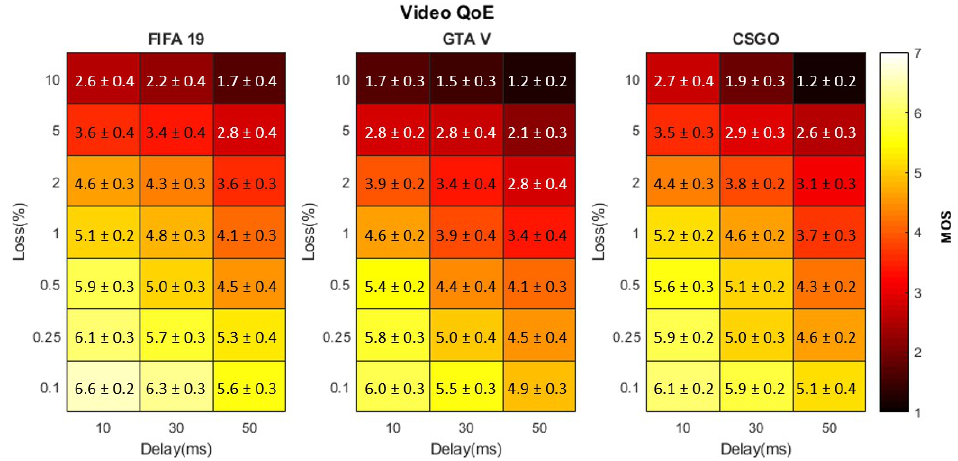
Figure 8. Heatmap of V-QoE (MOS with Confidence Intervals) for mixed network